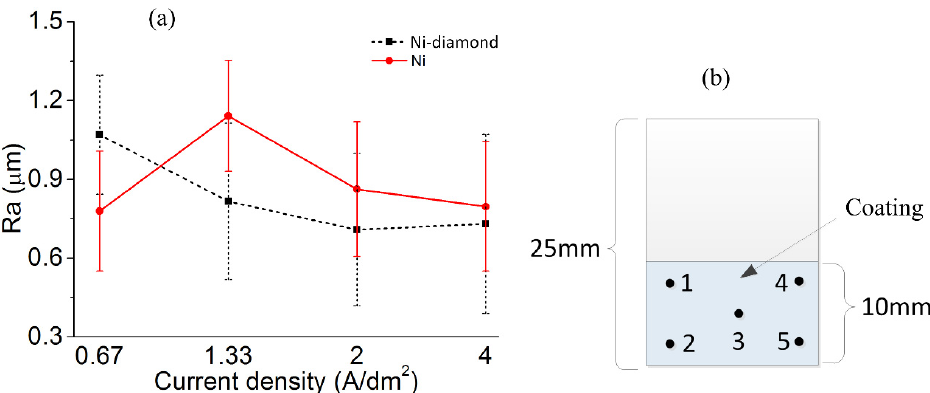
Figure 5. The comparison of surface roughness. ( a ) The roughness of Ni coatings and Ni–diamond coatings built by different current densities. ( b ) The sampling positions for surface roughness measurement. Position 3 was located at the center. Positions 1, 2, 4 and 5 were 2 mm from the edges.